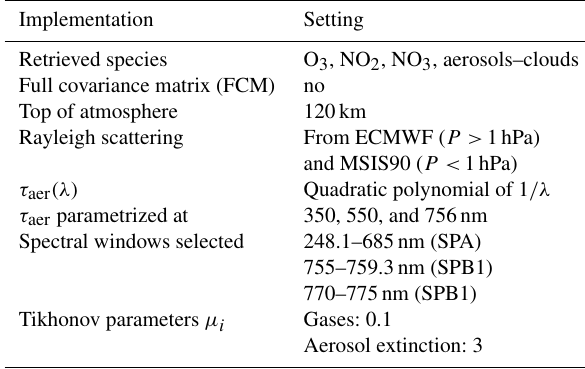
Table 5. Summary of the main configuration settings for the Aer- GOM v1.0